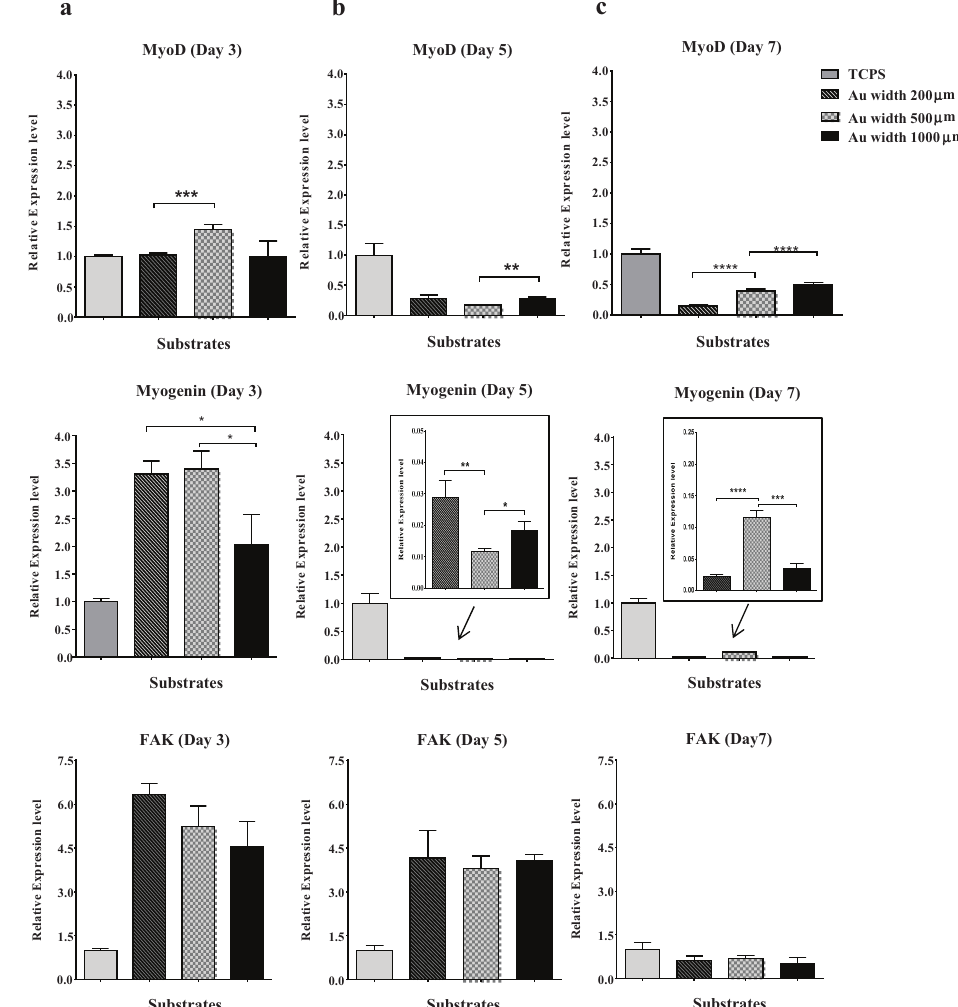
Figure 5. Effects of micropattern geometries on gene expression in myoblasts. RT-PCR analysis of genes associated with myogenesis of myoblast C2C12 cells, including MyoD, myogenin and FAK, on micropatterned GlcNAc6-SAMs, were observed after ( a ) three days; ( b ) five days; and ( c ) seven days of culture. Values are means ± standard error of mean. Statistically significant differences ( n = 9 per sample); * p < 0.05; ** p < 0.01; *** p < 0.001 and **** p < 0.0001, by t -test.